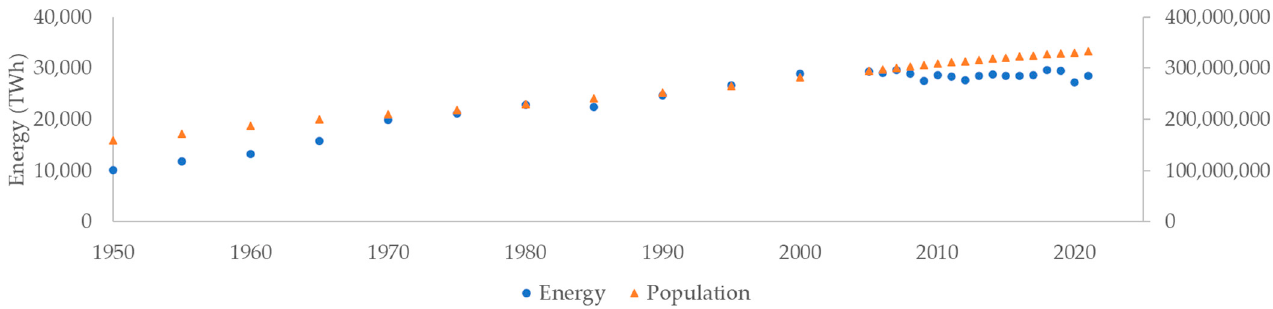
Figure 3. US historical population and total energy consumption from 1950 to 2021 [26,28].